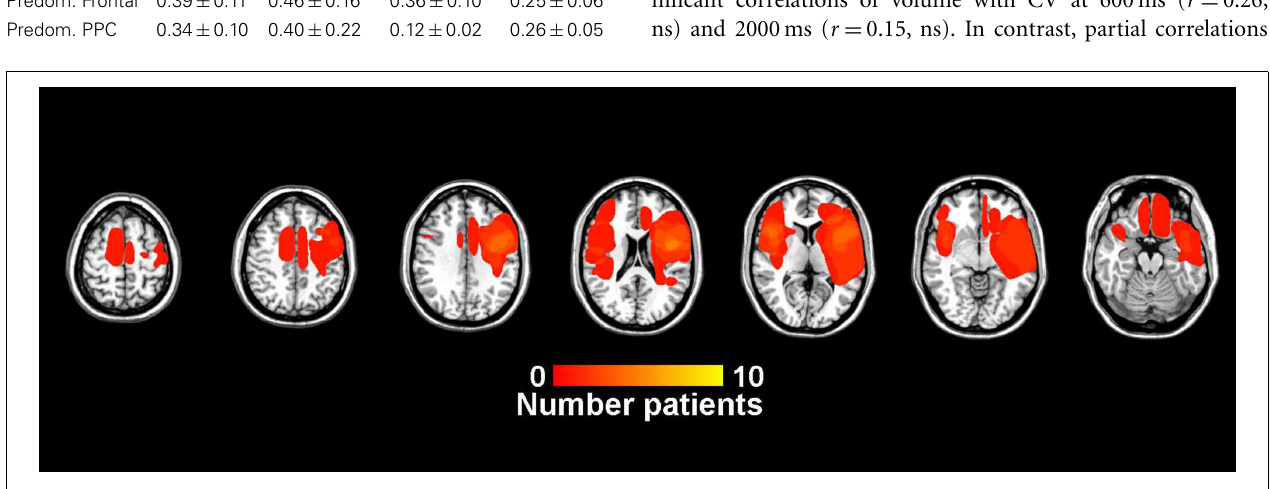
FIGURE 4 | Lesion overlap for patients in the predominantly frontal lesion